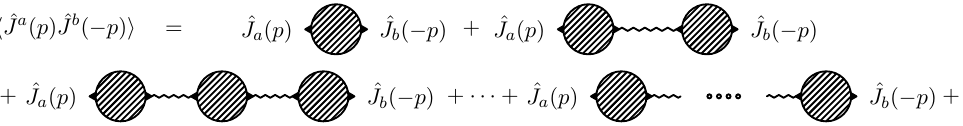
Figure 18 . The two-point function of the boundary current ^ J . The shaded blob represents the one-photon irreducible two-point function (cid:6)( p ), by which we mean the sum of all the diagrams that cannot be disconnected by cutting a photon line. The full two-point function can be obtained in terms of (cid:6), via the geometric sum shown in the (cid:12)gure.